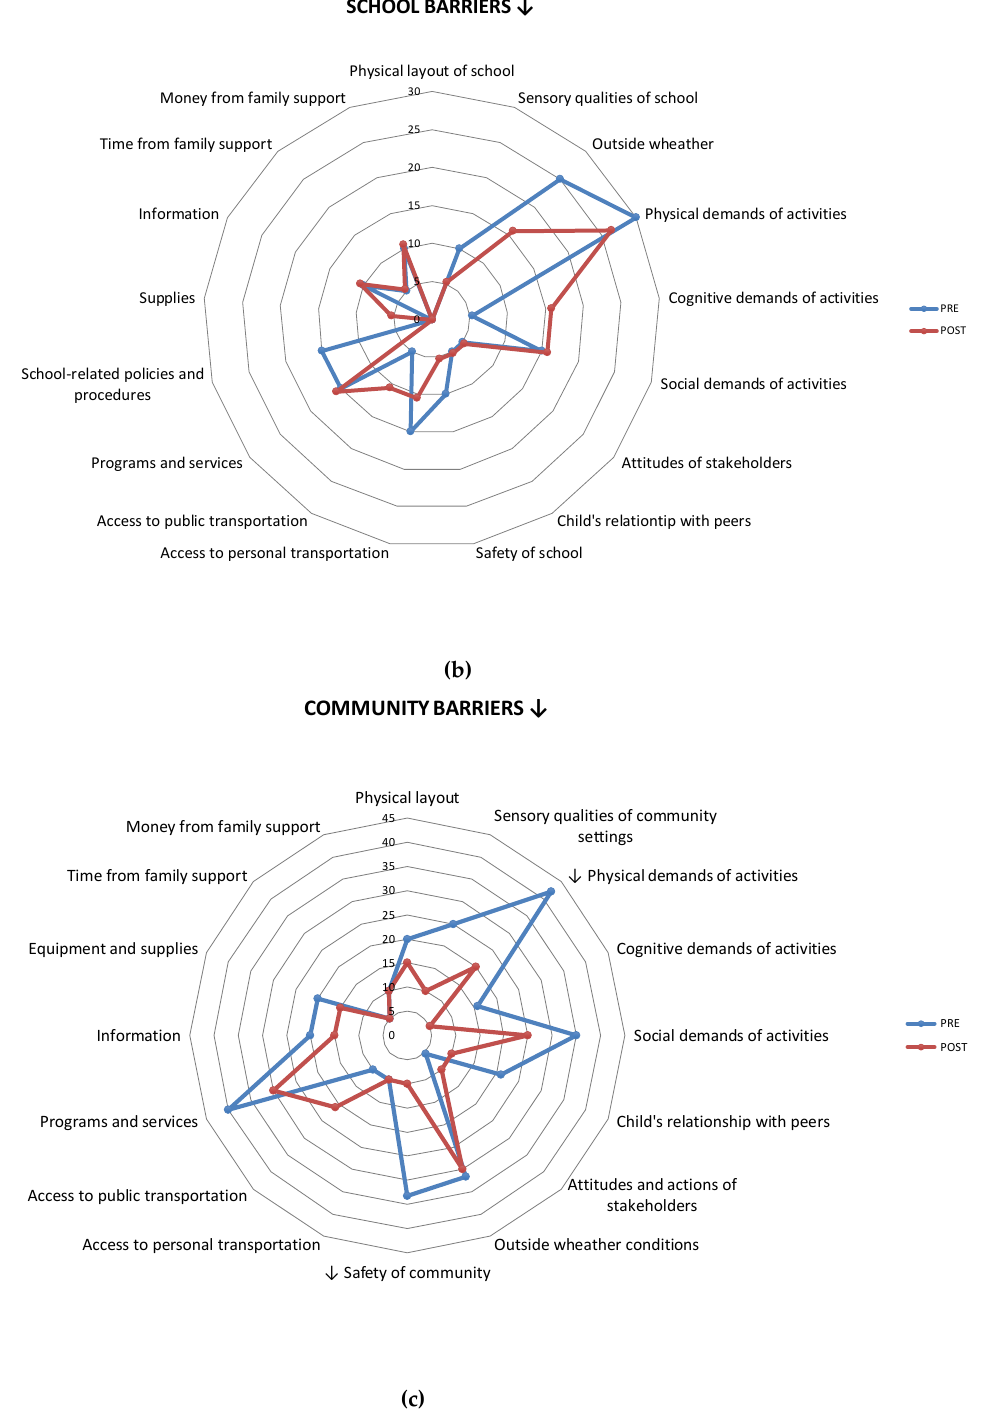
Figure 3. Percentage of parents (out of 20) who reported an environmental component as being a barrier in the home ( a ), school ( b ), and community ( c ) settings. ↓ = Decrease in at least 20% of sample. * p < 0.05